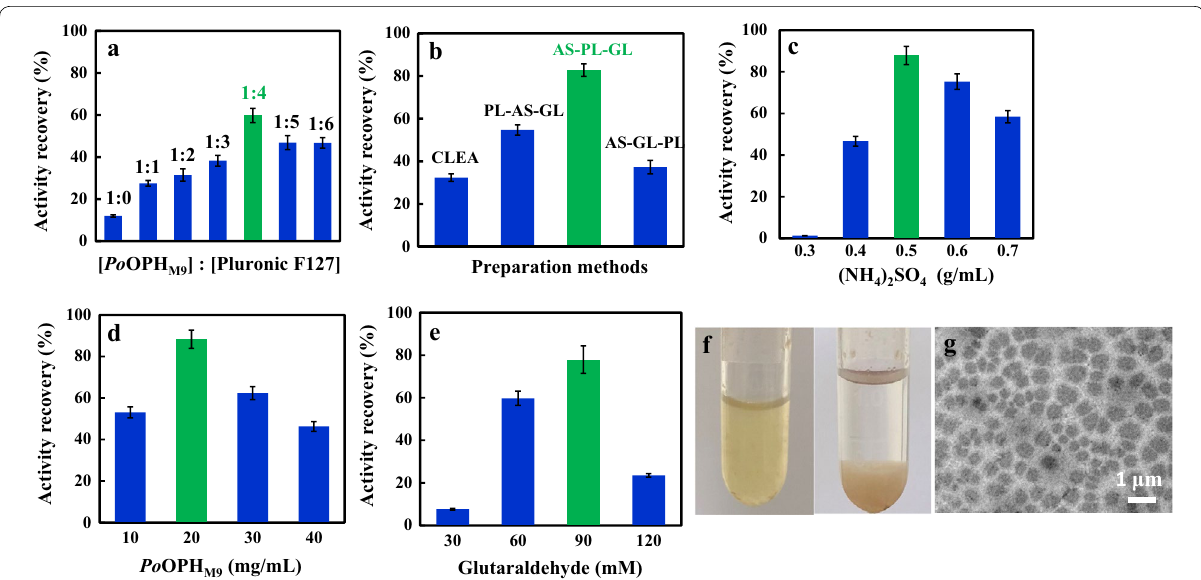
Fig. 2 The mass ratio of Po OPH M9 to Pluronic F127 ( a ), the different order of adding Pluronic F127 ( b ) and the concentrations of ammonium sulfate ( c ), the free enzyme ( d ) and glutaraldehyde ( e ) were optimized for preparing the immobilized catalyst CLEPC. The immobilized enzymes were distributed in aqueous phase during the enzymatic reaction ( f , left) and easily recovered by centrifugation ( f , right). g The transmission electron microscopy of CLEPC showed the aggregation of immobilized enzymes with the mean diameter of 0.66